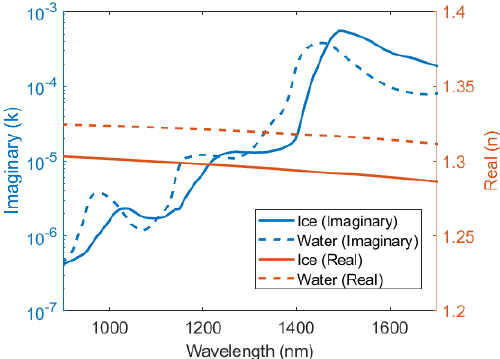
Figure 1. Complex refractive index of ice and liquid water at 0 ◦ C across the near-infrared region ranging from 900–1700nm, which is the same range measured by the Resonon Pika NIR-320 hyper- spectral